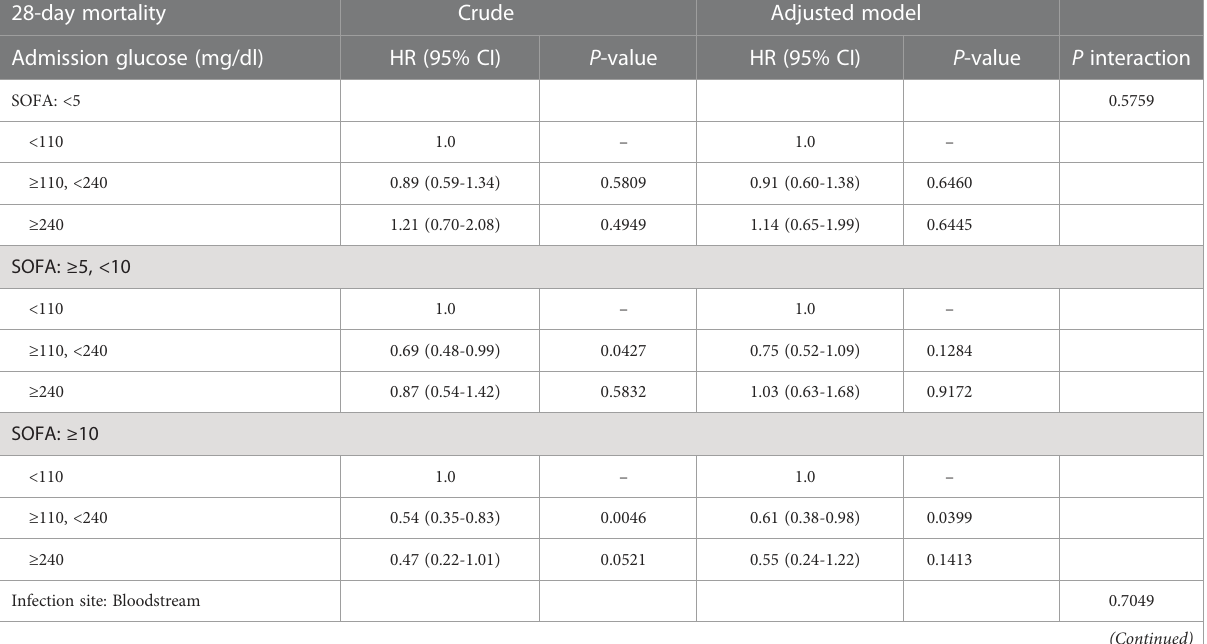
TABLE 5 Association of in fl ection point grouping of glucose with 28-day mortality strati fi ed by different scores of SOFA and infection site. 28-day mortality Crude Adjusted